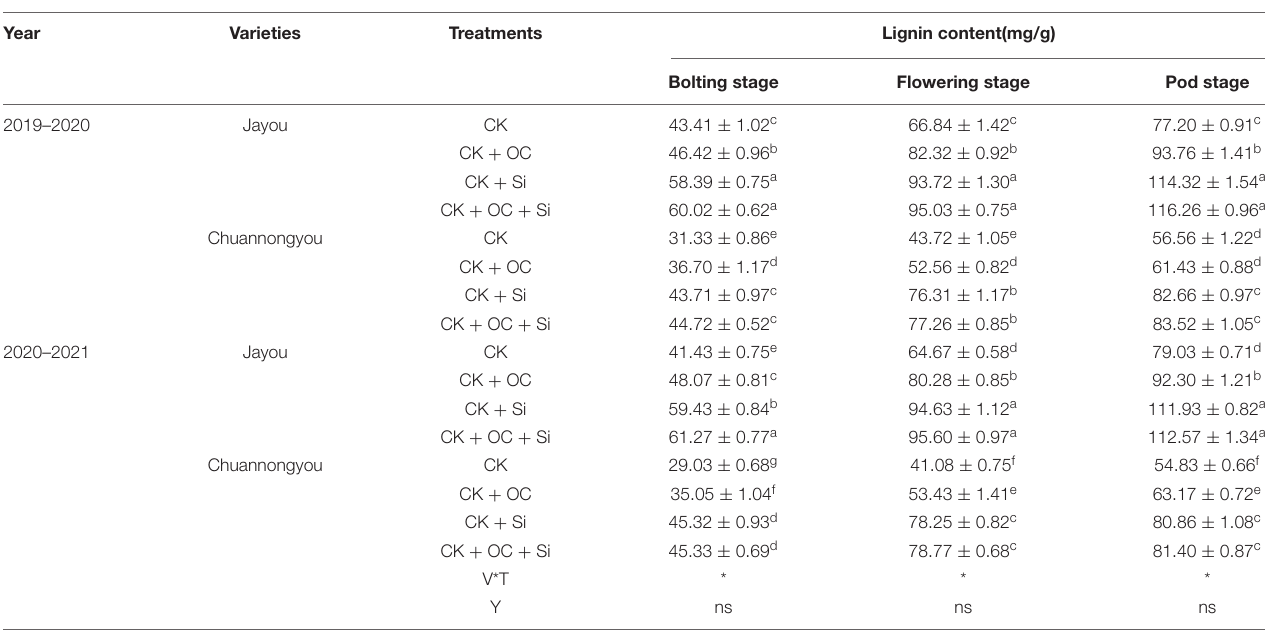
Different lower-case letters indicate significant differences among treatments at p ≤ 0.05 (LSD test) with the means (n = 3) of values. The CK, CK + OC, CK + Si, and CK + OC + Si represent the conventional fertilization, conventional + organic carbon fertilization, conventional + silicon fertilization treatment, and conventional + organic carbon + silicon fertilization treatment. V, T, and Y represent the variety, treatment, and year, while * and ns indicate the significance and non-significance,